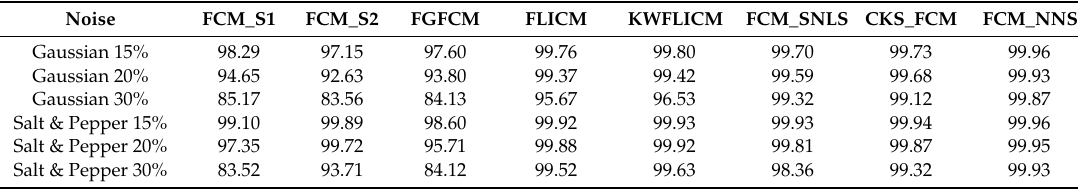
Table 3. Segmentation accuracy ( SA %) on the synthetic image.